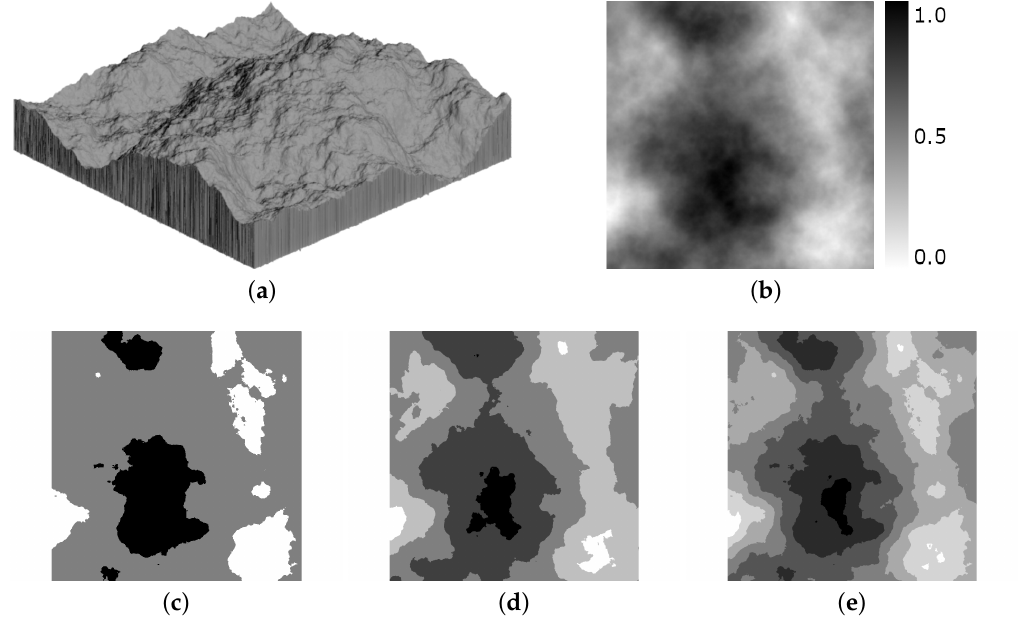
Figure 8. Materials layer generated by the Circular Fault Formation (CFF) method and interpreted as a grey-scale map (grid resolution: 1024 × 1024; fault radius (each): r = 256; fault height (max in centre): 0 (cid:54) ∆ h (cid:54) 1; total faults: 9999). ( a ) Geometric layer. ( b ) Initial map. ( c ) mat = 3. ( d ) mat = 5. ( e ) mat =